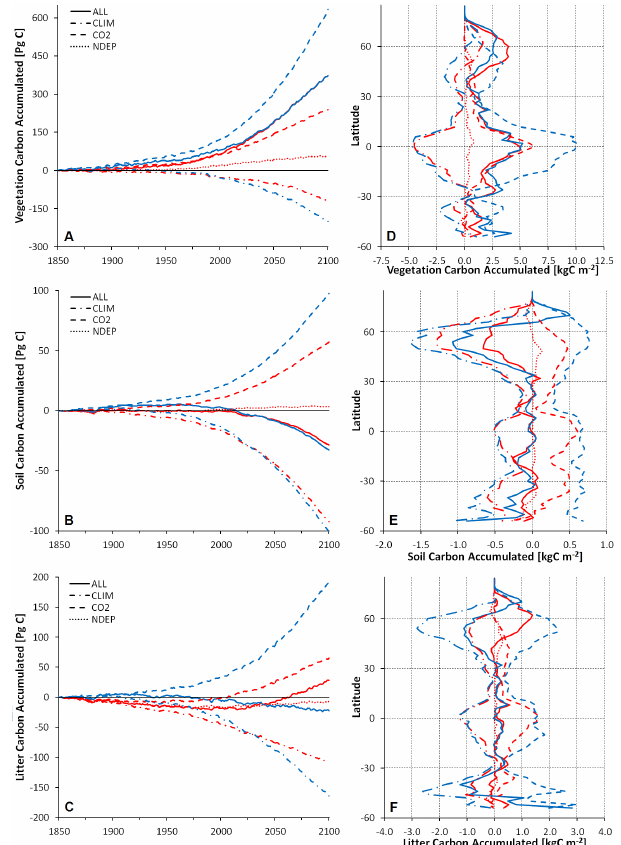
Figure A1. Cumulative vegetation (a) , soil (b) , and litter (c) C se- questrated between 1850 and 2100 simulated with historical and future change in climate (CLIM), atmospheric [CO 2 ] (CO2), N de- position (NDEP) alone, and all together (ALL). (d–f) show accu- mulated C by latitude over the period 2000–2100. Blue lines C-only version and red lines are C–N version.